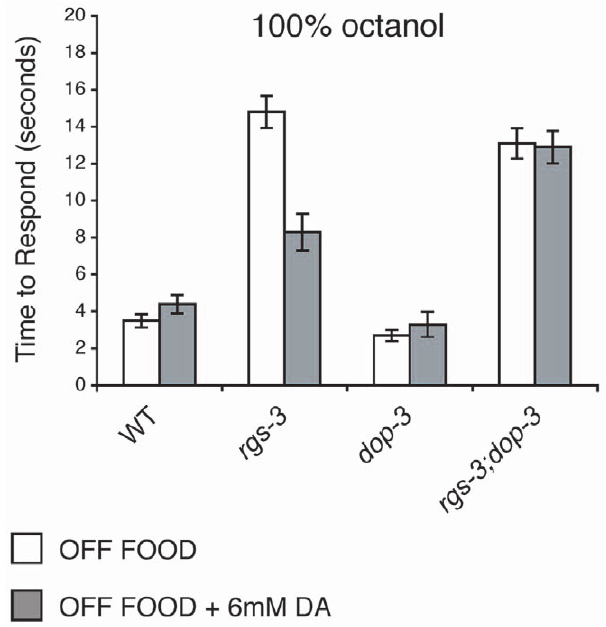
Figure 3. DOP-3 is required for the dopamine rescue of rgs-3 octanol avoidance. Exogenous dopamine (DA) restores the avoid- ance response of rgs-3 mutant animals to 100% octanol (p , 0.0001 when comparing rgs-3 + / 2 DA). Loss of DOP-3 function blocks the DA rescue of the rgs-3 response to octanol (p . 0.5 when comparing rgs- 3;dop-3 + / 2 DA). Alleles used: rgs-3(vs19) and dop-3(vs106) . WT = the N2 wild-type strain. The time to respond is shown. n $ 40. Error bars represent the standard error of the mean (SEM).